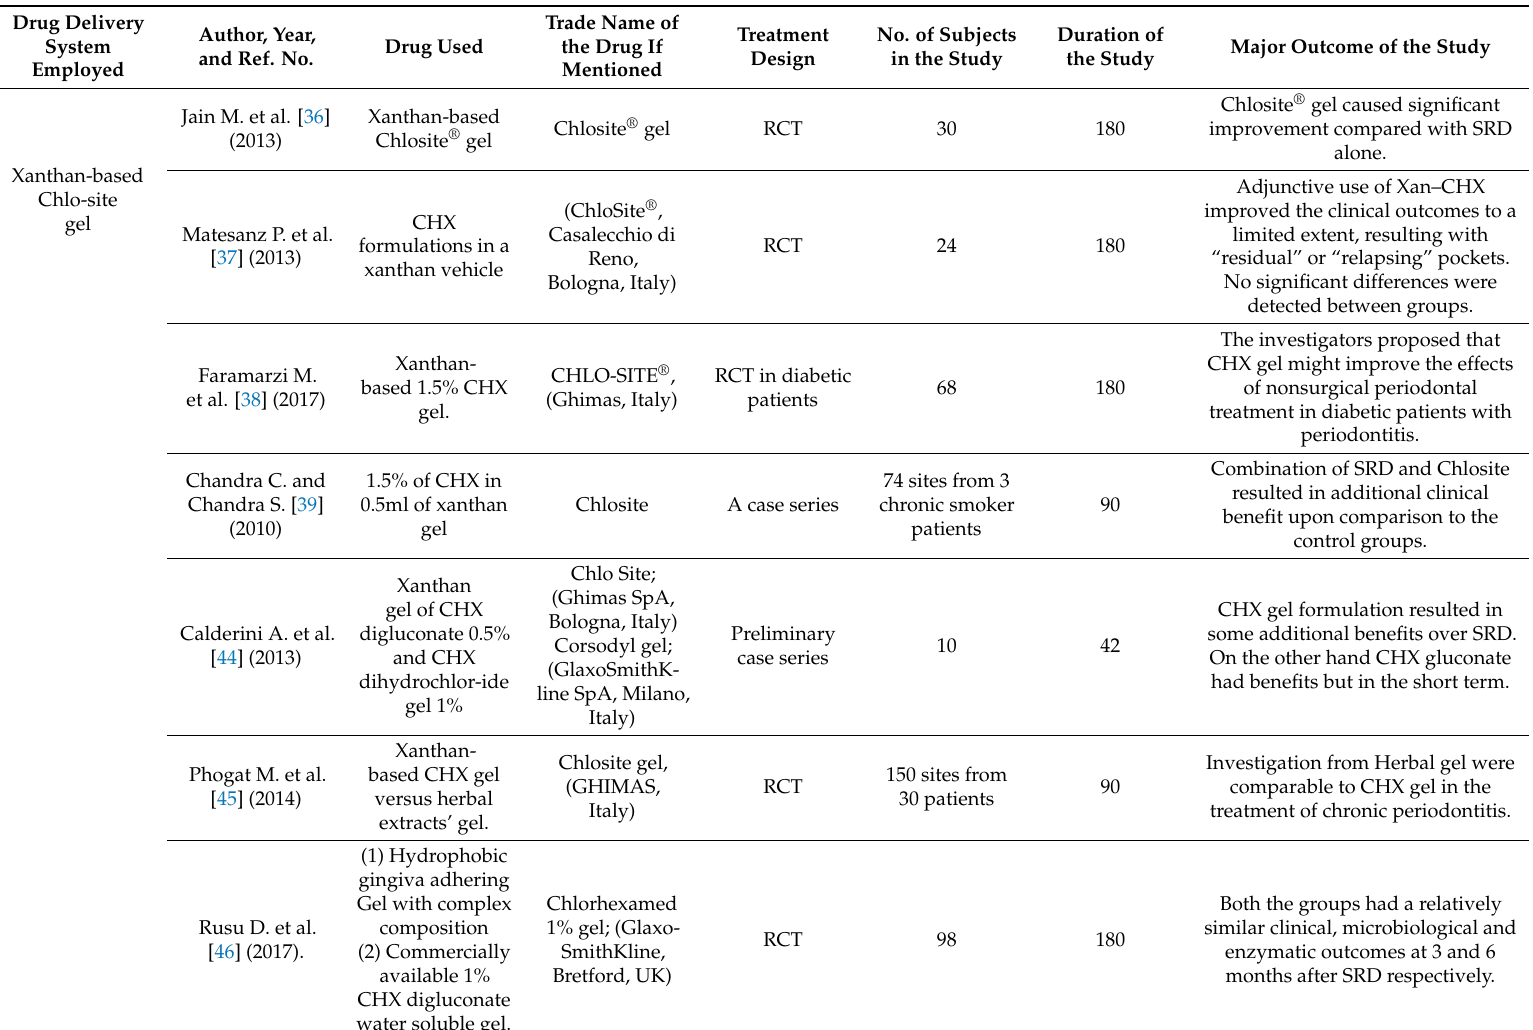
Table 3. Detailed study summary of investigated gel forms across the globe in the treatment of chronic periodontitis in the past 10 years. Drug Delivery